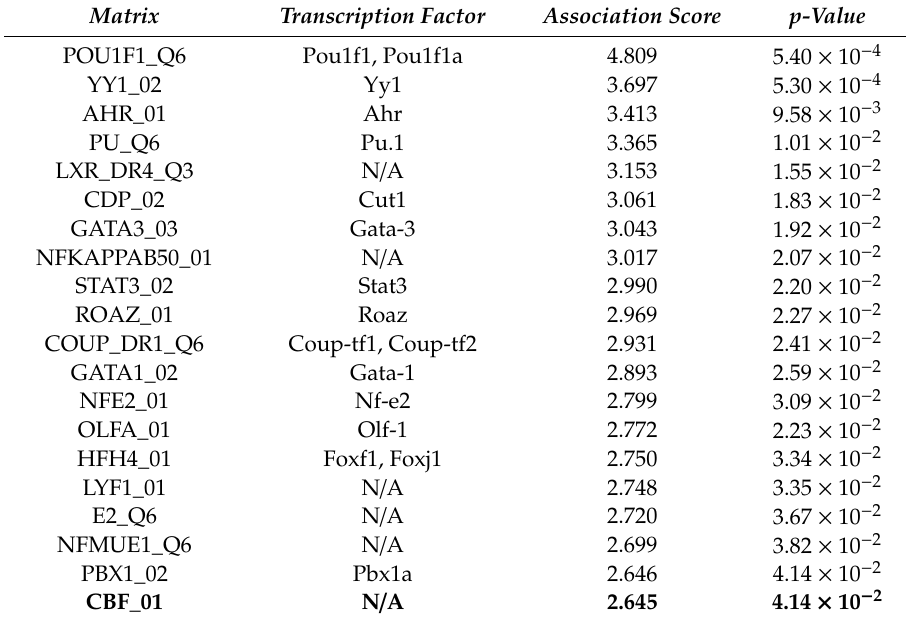
Table 4. Distal analysis ( ± − 10 kb) of genes commonly a ff ected by siRNA SH inhibition and ML114 treatment.